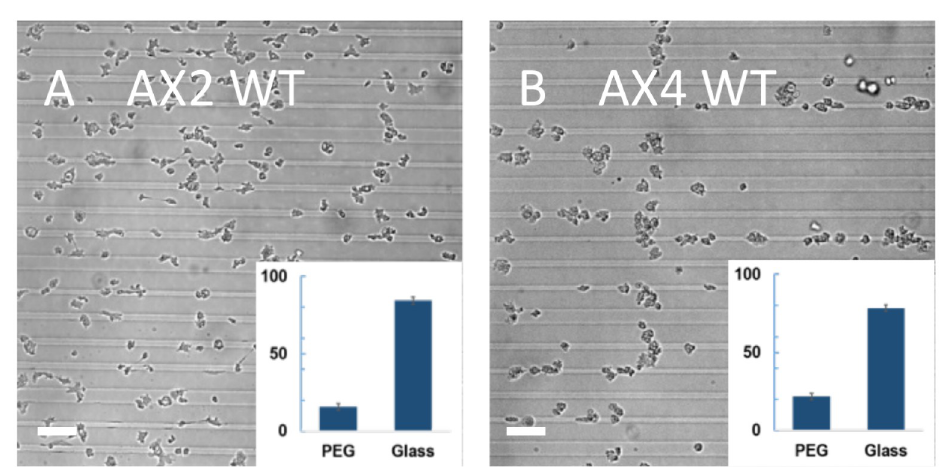
Fig 4. Vegetative cells on micropatterned substrates. A) Micrographs of WT AX2 (A) and AX4 (B) cells, 10 min after plating. Insets: relative coverage of cells on PEG-gel and glass stripes. For both strains, there is a major bias towards the adhesion to glass vs. PEG-gel. (Scale bar: 50 μm